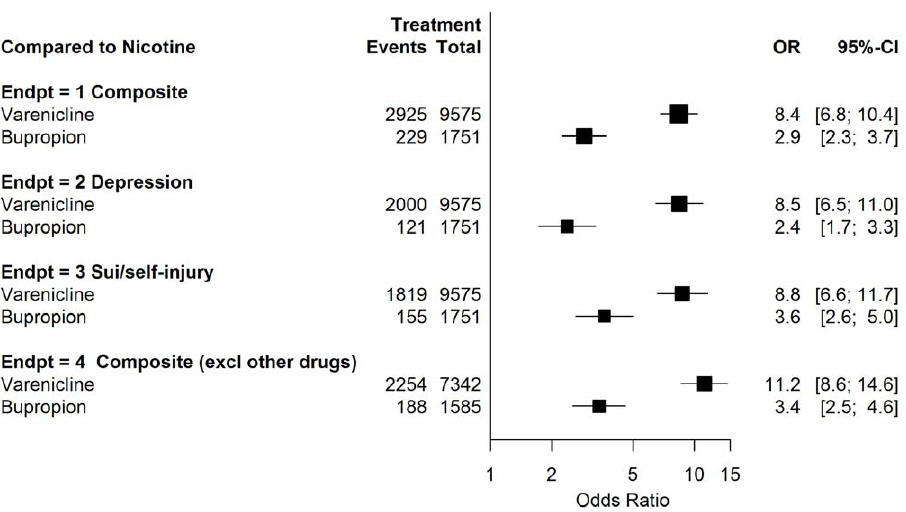
Figure 1. Varenicline, bupriopion versus nicotine replacement.